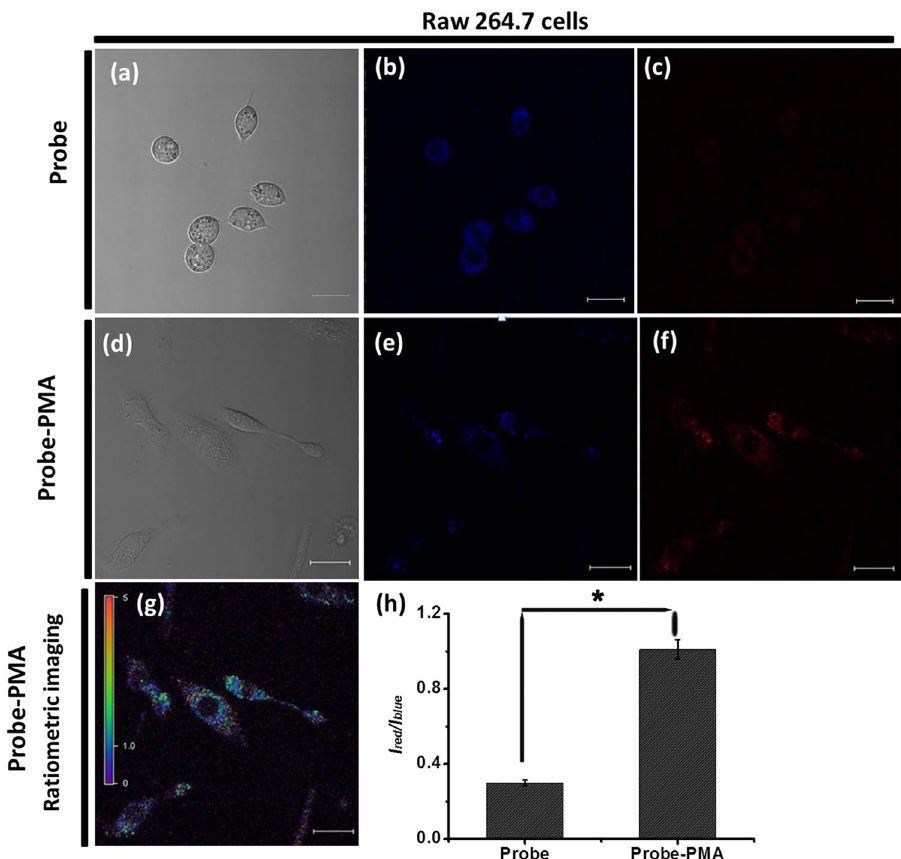
Figure 7. Image of endogenous H 2 O 2 in RAW 264.7 cells untreated and treated with PMA. ( a ) Bright-field image of cells untreated with PMA, ( b ) Images of cells untreated with PMA in the blue emission channel ( λ ex = 405 nm, λ em = 425–475 nm); ( c ) Images of cells untreated with PMA in the red emission channel ( λ ex = 405 nm, λ em = 570–620 nm); ( d ) Bright-field images of cells treated with PMA; ( e ) Images of cells treated with PMA in the blue emission channel ( λ ex = 405 nm, λ em = 425–475 nm); ( f ) Images of cells treated with PMA in the red emission channel ( λ ex = 405 nm, λ em = 570–620 nm); ( g ) Ratiometric image of cells untreated with PMA; ( h ) The ratio of emission intensities profiles in RAW 264.7 cells untreated and treated with PMA. Scale bar = 20 μ m. Statistical analyses were performed with a Student’s t -test ( n = 4). * P < 0.001 and the error bars represent standard deviation ( ±